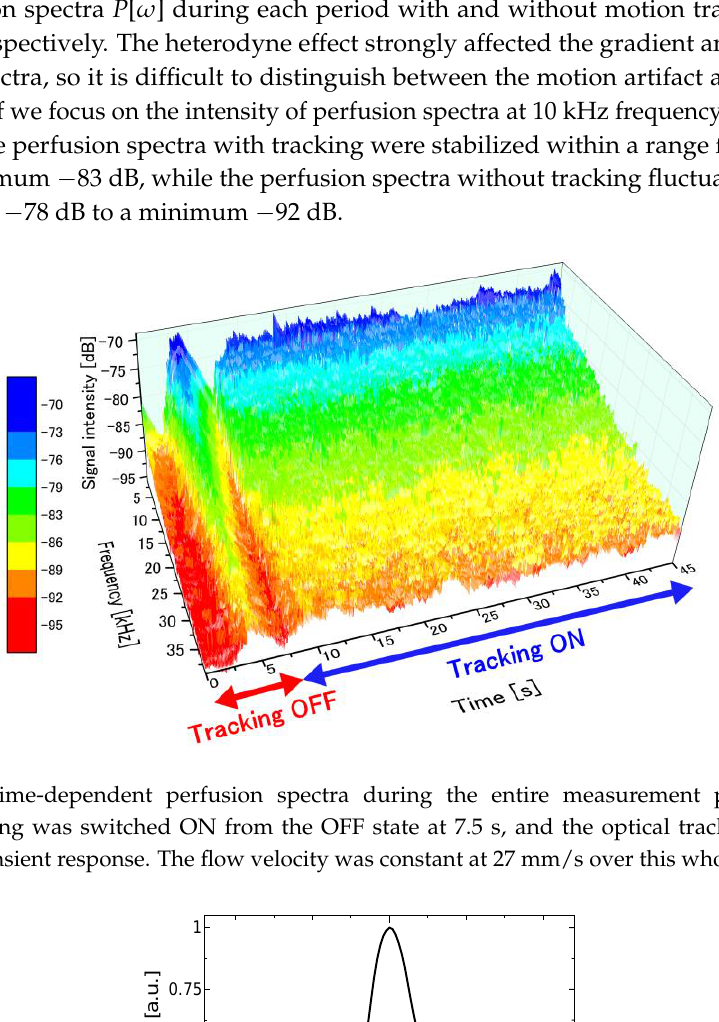
( a ) ( b ) Figure 8. Stabilization of perfusion spectra with motion tracking. Flow velocity was constant at 27 mm/s. ( a ) Perfusion spectra with tracking OFF for 2, 3 and 4 s; ( b ) with tracking ON for 11, 12, and 13 s.